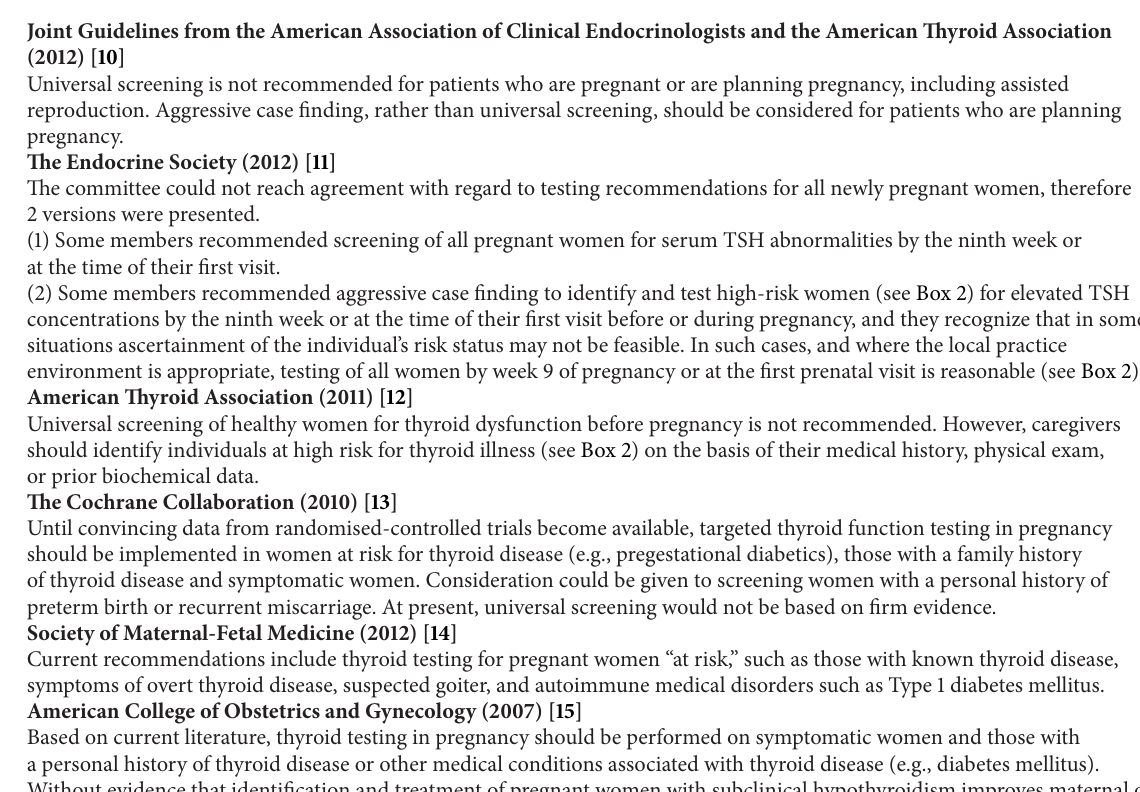
Box 1: Screening recommendations for thyroid disorders in